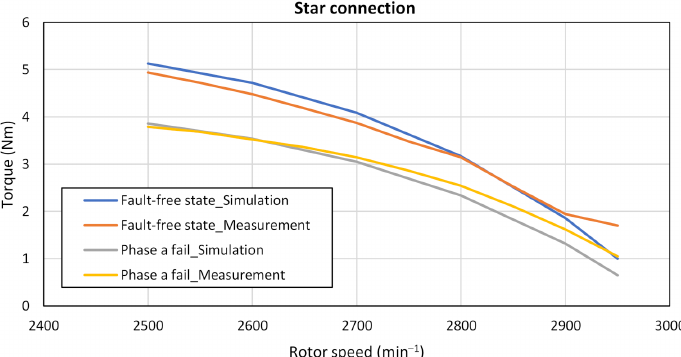
Figure 26. Torque measurement and simulation of 5 fIM for fault-free condition and failure of one phase in a star connection.